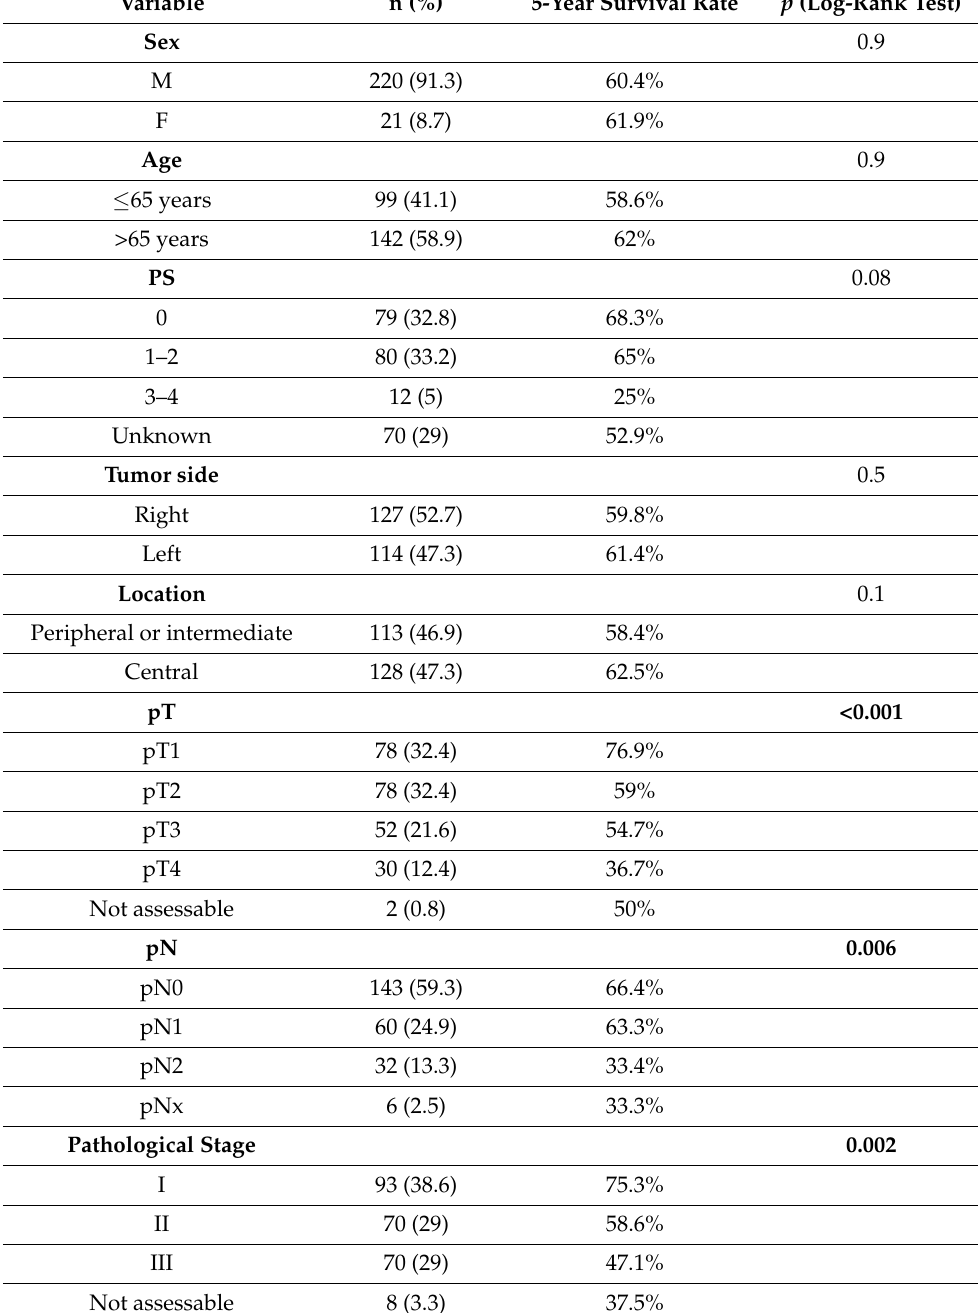
Table 1. Clinical and histopathological data in relation to 5-year overall